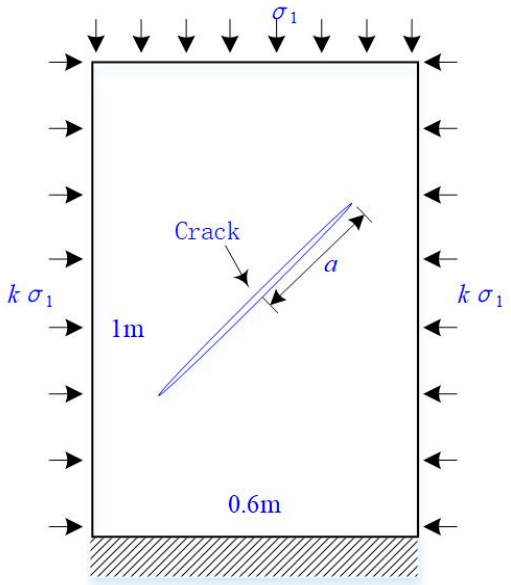
Figure 4. Numerical simulation of grouting crack damage, a is the crack half length, k is the side pressure coefficient.